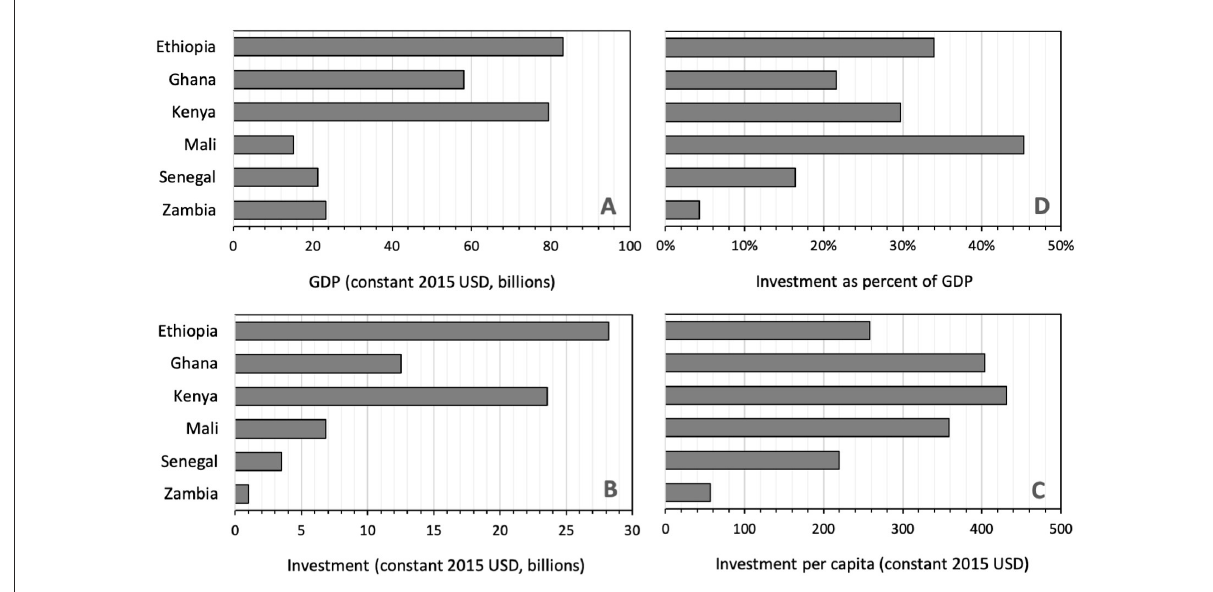
FIGURE3 Gross domestic product (GDP) (A) country investment in agriculture, forestry and fishing (B) , investment per-capita (C) and investment as percent of GDP (D) ; constant 2015 USD, 2016–2020 average. Source: World Bank World Development Indicators database, and